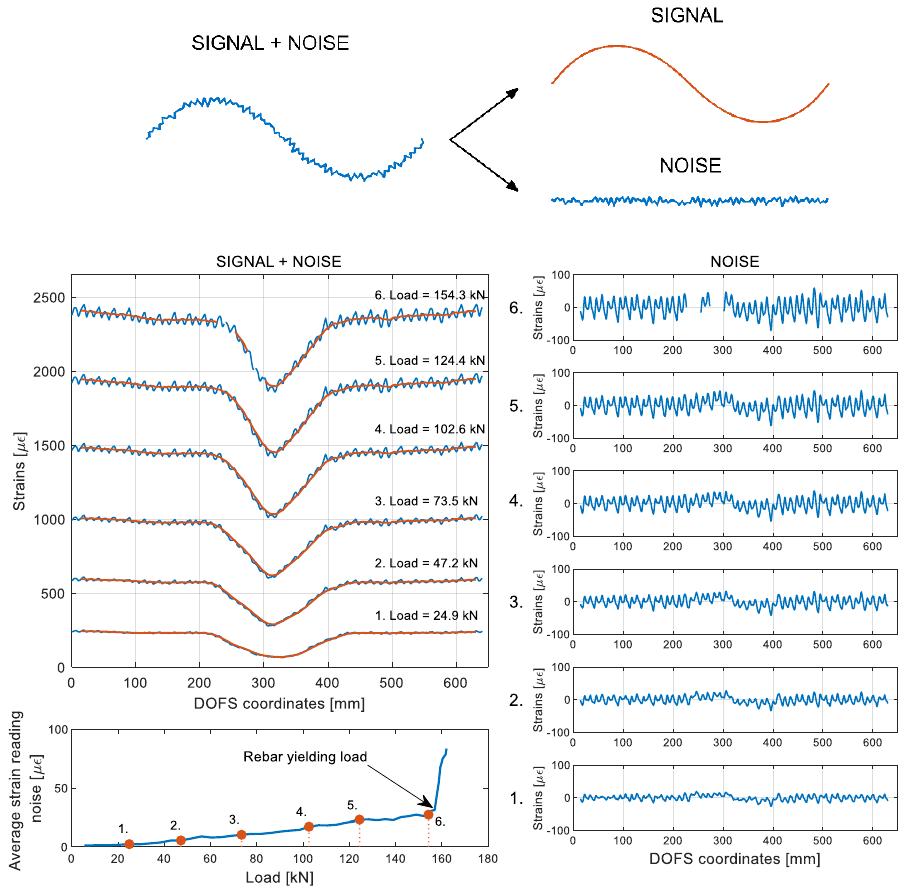
Figure 13. Distinction of signal and noise for an example curve (top) and evolution of the rib-induced noise with the load of member 15D20_21.